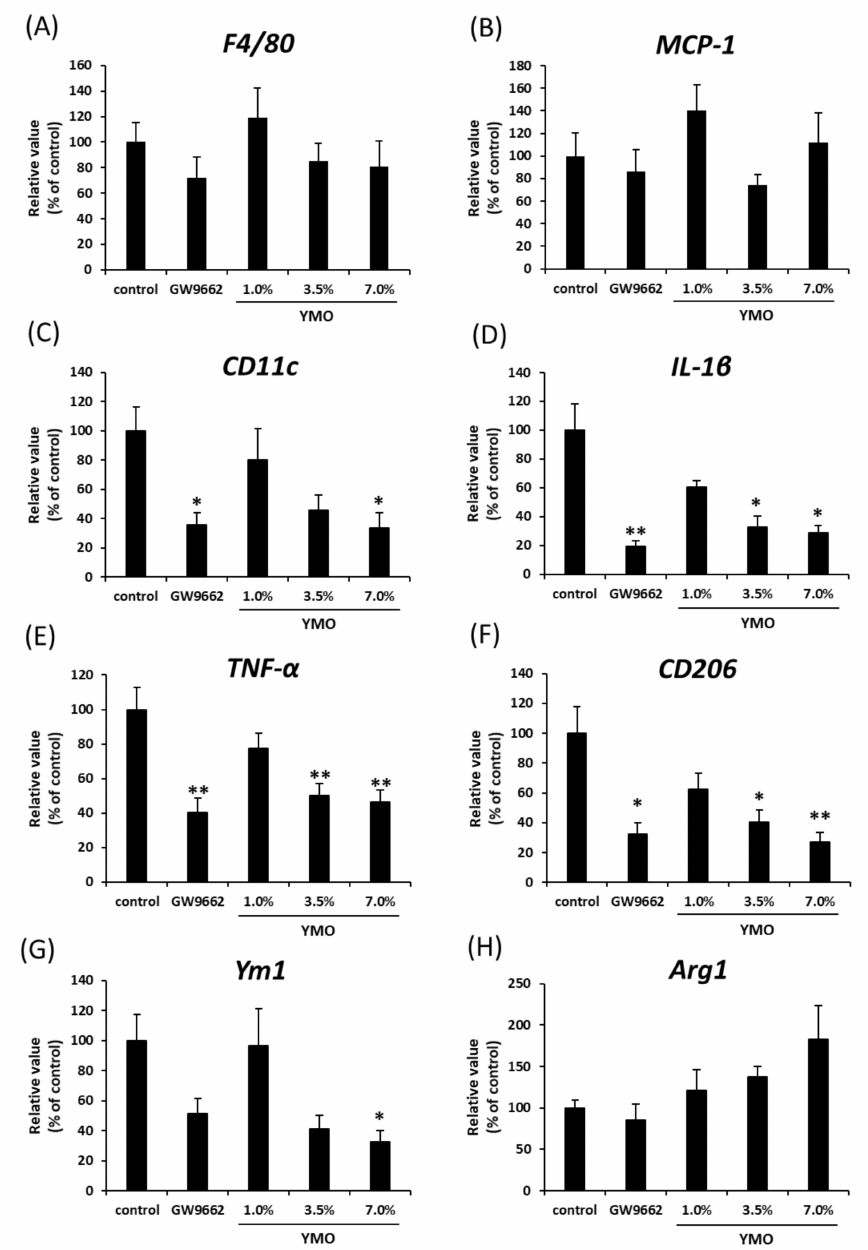
Figure 7. Effect of YMO on the expression of macrophage marker genes in perirenal adipose tissue in KK-A y mice. mRNA expression levels of F4/80 ( A ), MCP-1 ( B ), M1 macrophage markers ( C – E ), and M2 macrophage markers ( F – H ) in perirenal adipose tissue were measured as described in Figure 3 legend. Values are mean ± SE, n = 10–11. ** p < 0.01, * p < 0.05 versus